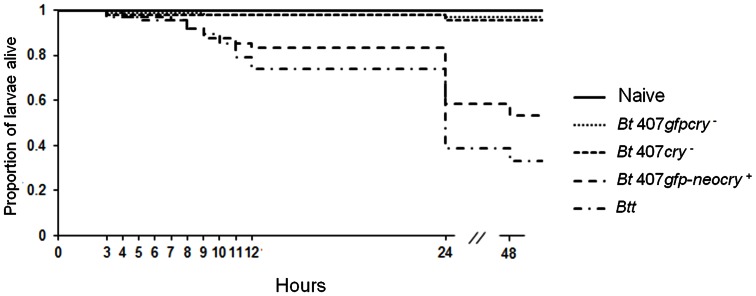
Larval mortality rate.Larvae of SB beetle population exposed for 3 hours to spore-containing diet. Mortality rate was monitored hourly starting from the third hour post initial exposure (PIE) till the twelfth hour PIE and then 24 and 48 hours PIE.